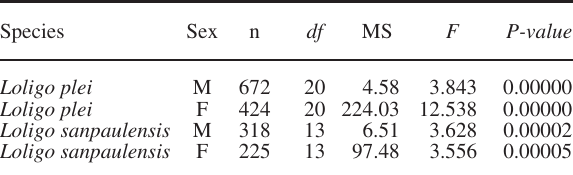
n: number of squid sampled; d.f : degrees of freedom; MS: mean